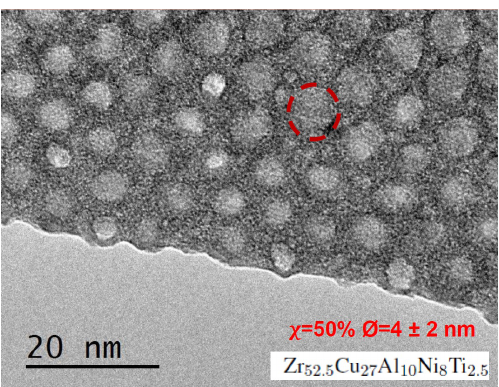
Figure 1. Transmission Electron Microscope image of a Zr-Cu-Al-Ti-Ni metallic glass with nano- crystalline inclusions, taken from